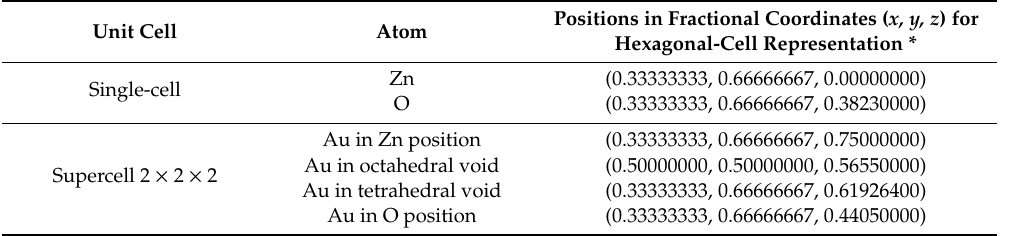
Figure 1. The structural models of Au:ZnO with the gold ion in ( a ) the substitutional position of zinc (Au–Zn), ( b ) the interstitial position of the octahedral void (Au–OctVoid), ( c ) the interstitial position of the tetrahedral void (Au–TetrVoid), ( d ) the substitutional position of oxygen (Au–O). The structural models are 2 × 2 × 2 supercells. Table 1. A description of the fractional coordinates of atoms in the ZnO model [35] together with four di ff erent Au positions in ZnO.